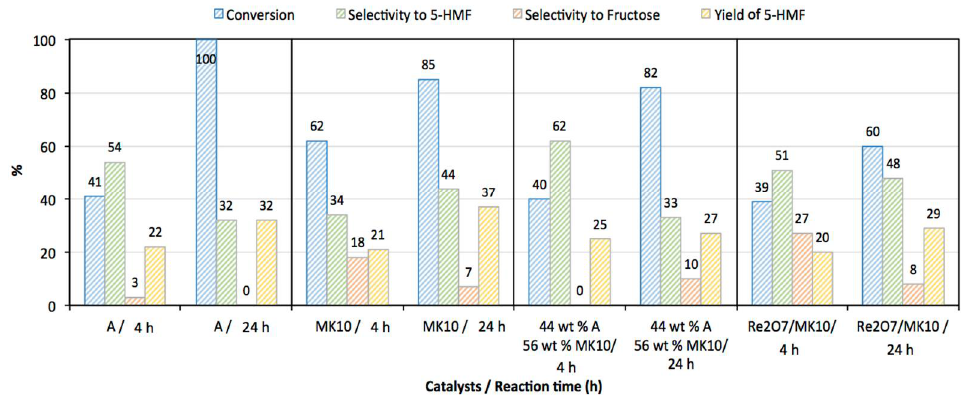
Figure 7. Effect of the reaction time, 4 h and 24 h, for several catalysts. Reaction conditions: 2.4 g of glucose, 0.6 g of catalyst mixture, catalyst/glucose wt ratio = 0.25, solvent volume ratio (THF:H 2 O) = 35:15, temperature = 140 ° C.